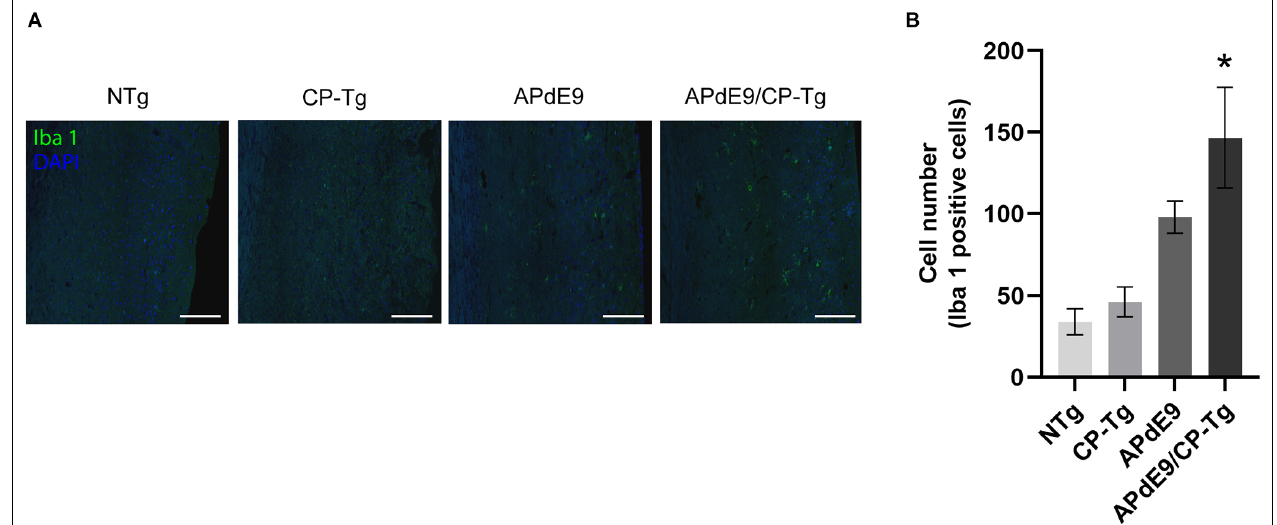
FIGURE 10 | Increase of neuroinflammation in APdE9/CP-Tg mice. Quantification of activated microglia, measured by Iba 1 staining, in the cortex of 17–20-month-old NTg, CP-TG, APdE9, and APdE9/CP-Tg mice. (A) Representative two-dimensional images of Iba 1-positive microglia in whole coronal brain slices. Scale bar = 50 µ m. (B) Prostacyclin overexpression in the APdE9 mouse model significantly increases neuroinflammation measured by the presence of hyperactivated microglia in brain tissues. * p < 0.05 compared to NTg mice. n = 4 − 5 mice per